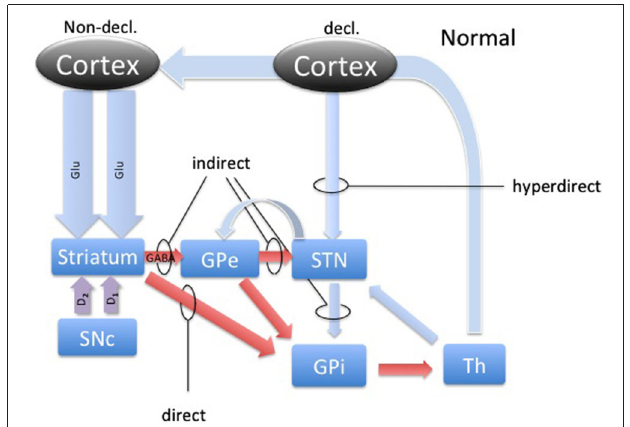
FIGURE 2 | Diagram of cortical and BG activity during a declarative memory task in a healthy control. The thickness of arrows represents the theoretical expected concentration change relative to the baseline depicted in Figure 1 . The gray-shaded area represents the part of the BG circuitry involved in declarative memory task. Green shadows represent activation and the red shadow represents suppression of the